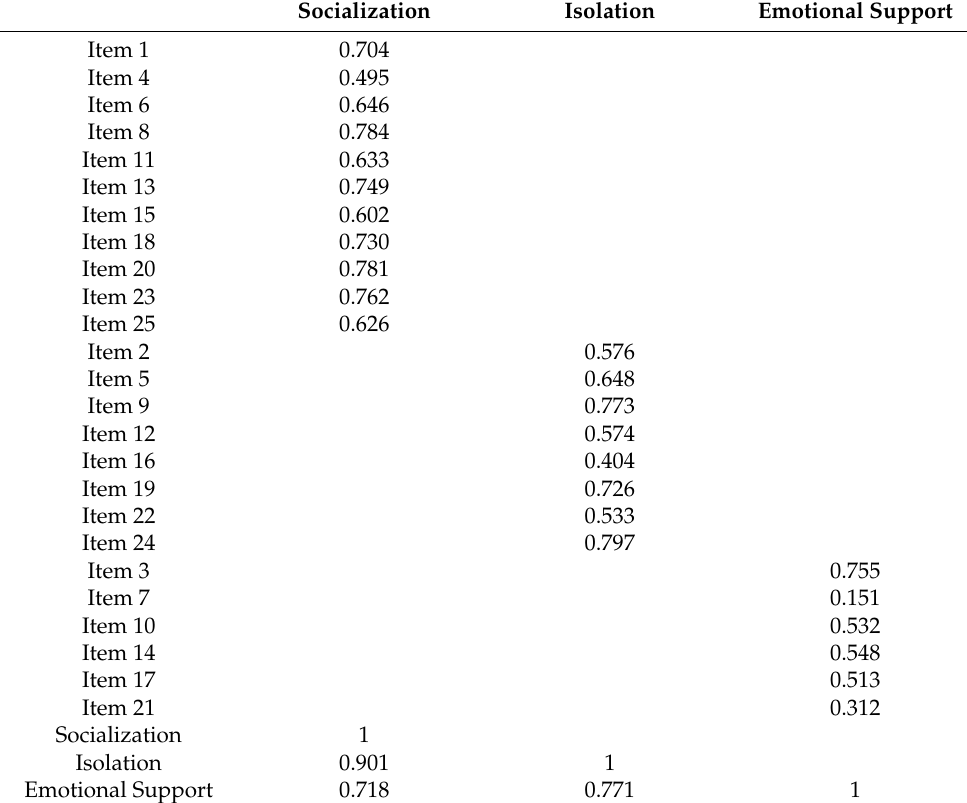
Table 1. Completely standardized factor loadings and latent correlations among the three factors of the HQ-25.